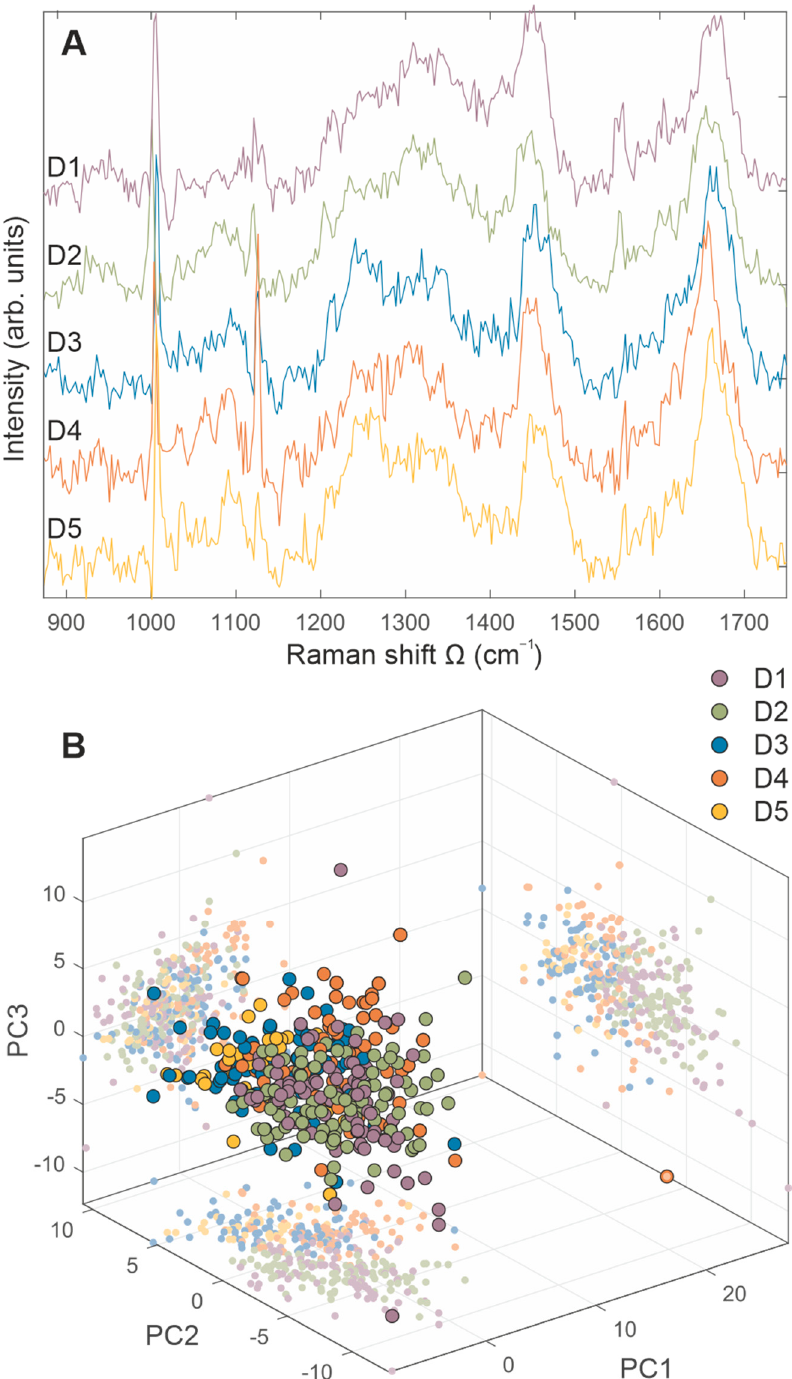
Figure 5. Comparative representation of BM-MSCs Raman spectra, derived from five donors. BM-MSCs were seeded on rounded CaF2 slides (Raman grade quality) and cultivated under standard conditions during 24 h. Before Raman scattering experiments, cells were washed with saline buffer and fixed with methanol for 10 min at the room temperature. On average, 50 to 100 cells per each cell population were analyzed. ( A ) Averaged Raman spectra of BM-MSCs for each donor are presented with purple (D1), green (D2), blue (D3), orange (D4), and yellow (D5) lines. ( B ) 3D PCA score plots (PC1–PC2 and PC1–PC3) are presented with purple (D1), green (D2), blue (D3), orange (D4), and yellow (D5)